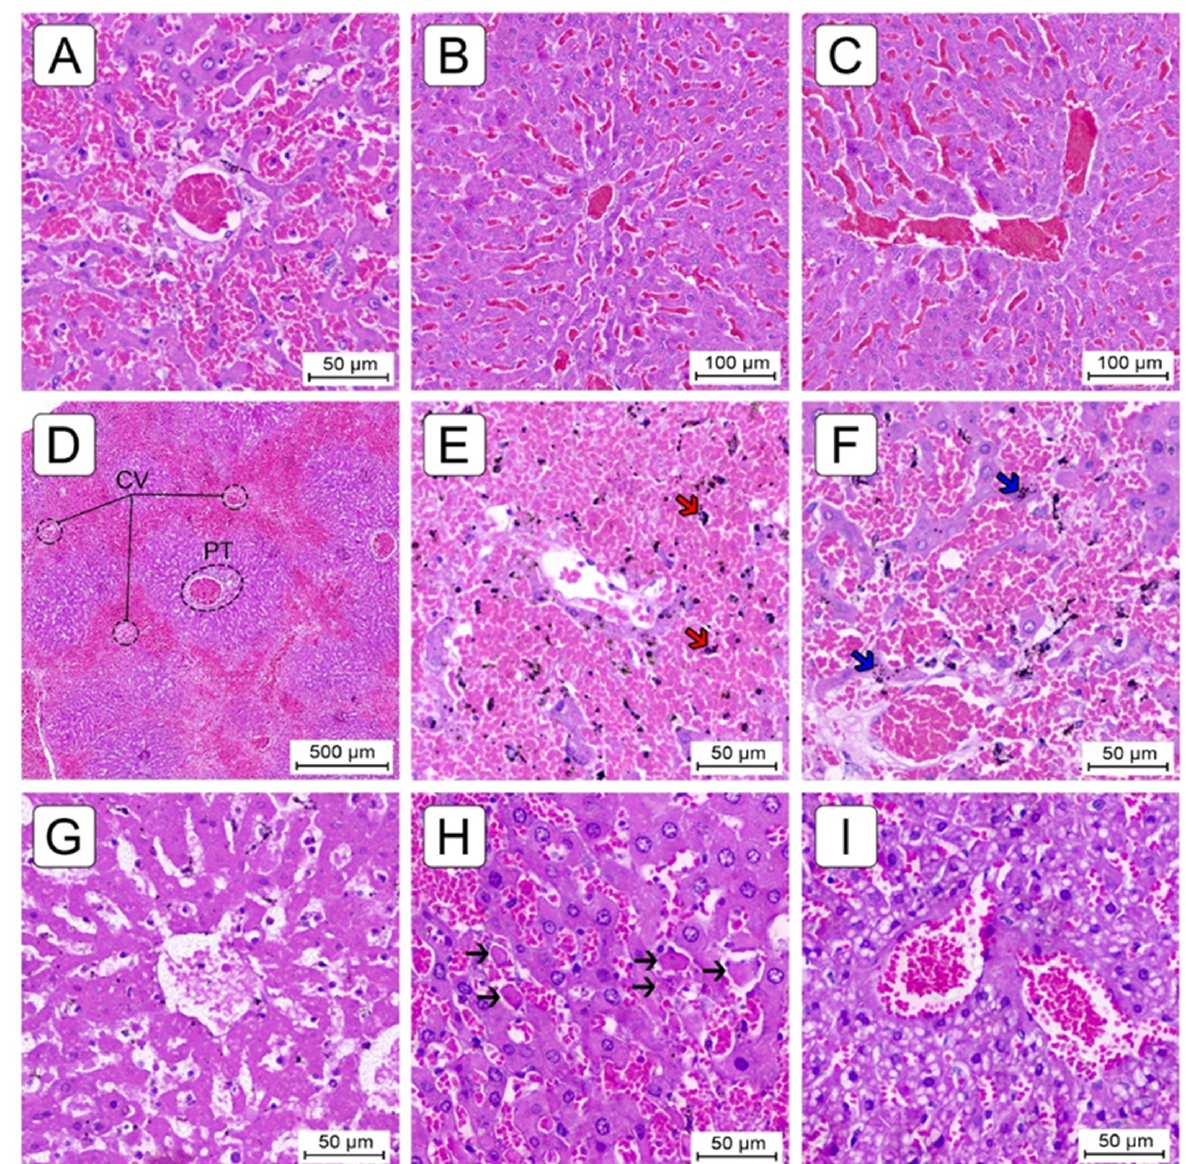
Figure 5. Histological changes in the livers of MCT animals. ( A ) Sinusoidal dilatation and congestion in centrilobular zone associated with the atrophy of centrilobular hepatocytes, with marked thinning of liver cell plates. ( B , C ) Sinusoidal congestion in zones 3 and 2 with preservation of centrilobular hepatocytes and liver cell plate thickness. ( D ) Marked centrilobular necrosis with bridging from one centrilobular vein (CV) to another. Intervening portal tracts (PT) and periportal parenchyma (zone 3) are preserved. ( E , F ) Centrilobular hemosiderin deposition, with the presence of dark brown granules inside the hepatocytes (blue arrows) and Kupffer cells (red arrows). ( G ) Coagulative necrosis of hepatocytes surrounding the CV, showing dense acidophilic cytoplasm associated with nuclear pyknosis, loss of nuclear details or absence of nuclei. ( H ) Hepatocyte apoptosis in early stage. Apoptotic bodies (black arrows) are generally surrounded by a clear halo and feature a condensed and eosinophilic cytoplasm, in contrast to adjacent normal hepatocytes, and either are devoid of chromatin or contain pyknotic or fragmented nuclear material. ( I ) Microvesicular steatosis, characterized by variably enlarged hepatocytes with very fine fat vacuoles. Hematoxylin-eosin